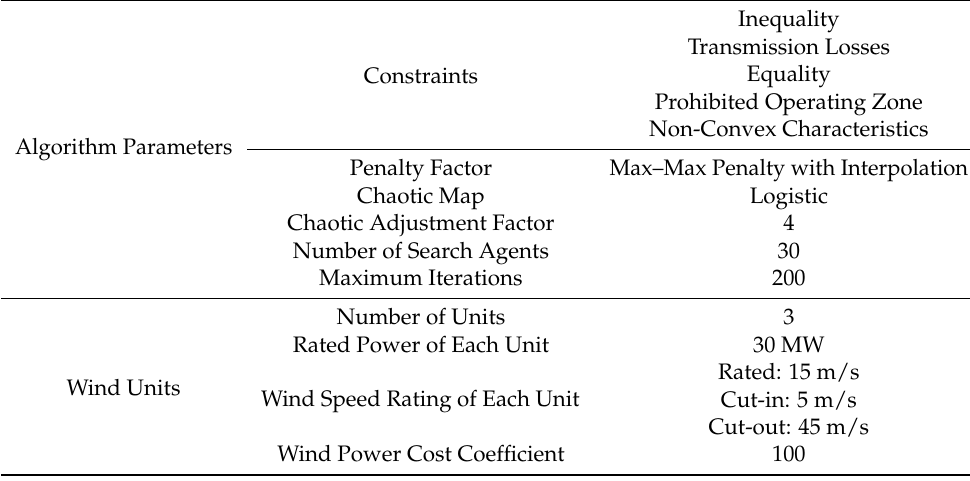
Table 32. Algorithm parameters, constraints, and renewable units